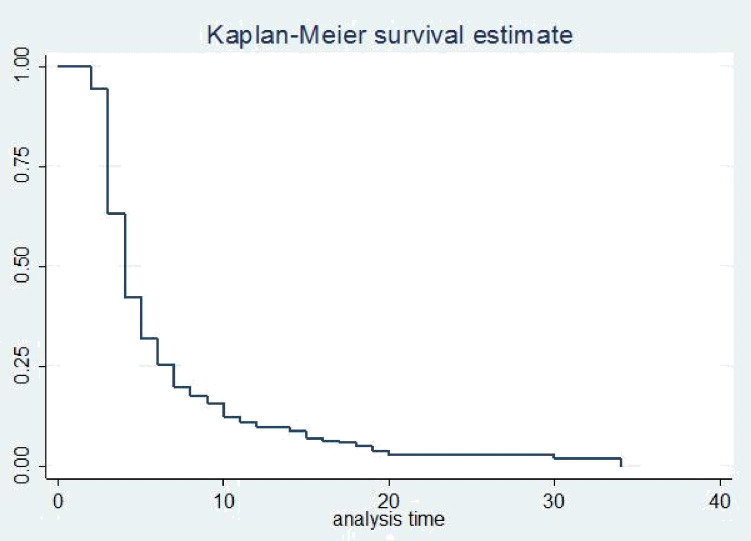
Kaplan-Meier survival estimate of recovery time among children with SCAP admitted to Debre Markos referral hospital, 2016 to 2018.